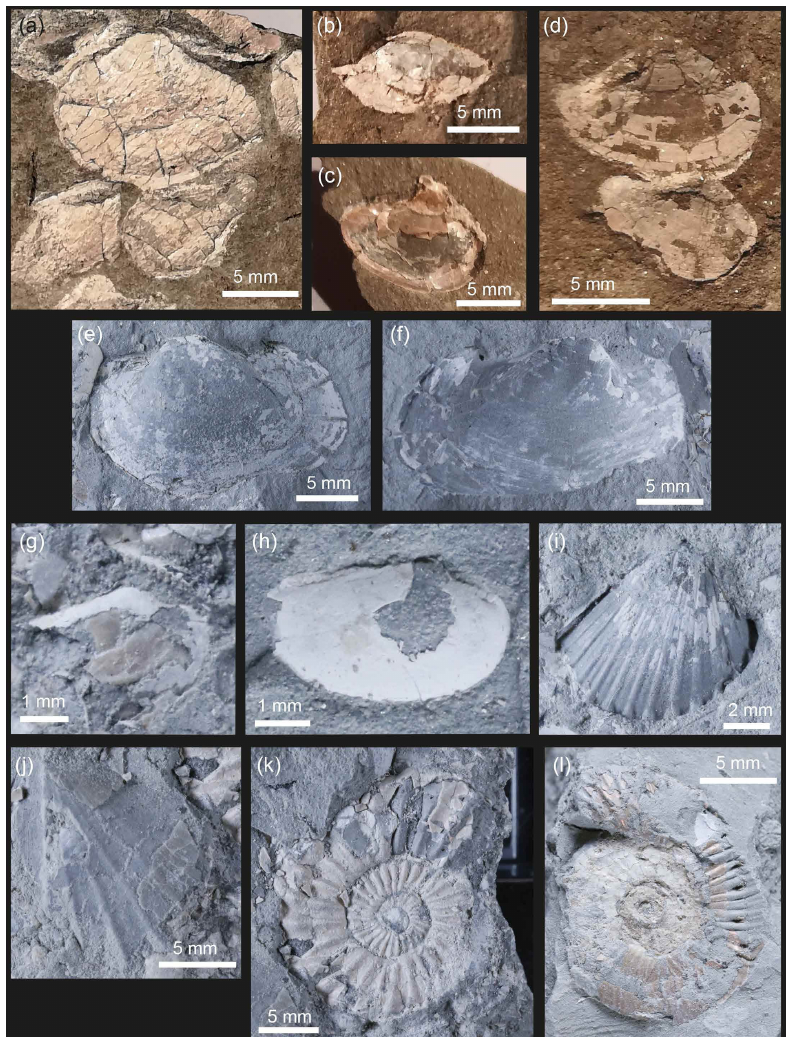
Figure 2. Selected specimens from the sampled successions. (a–d) Polovinnaya River section (Toarcian). (e–l) Warcq section (Pliens- bachian). (a) Dacryomya jacutica , specimen POL-29 (on the surface of a carbonate concretion). (b) Dacryomya jacutica , specimen POL-13. (c,d) Dacryomya jacutica , specimen POL-05. (e,f) Grammatodon sp., specimen ARD-01 (inner e and outer f mould after sampling of the shell). (g,h) Malletia sp. (i) Limea sp., specimen ARD-03 (inner mould after sampling of the shell). (j) Oxytoma sp. ind. (inner mould with remains of a calcite shell). (k) Aegoceras ? , specimen ARD-06. (l) Dactylioceratidae indet., specimen